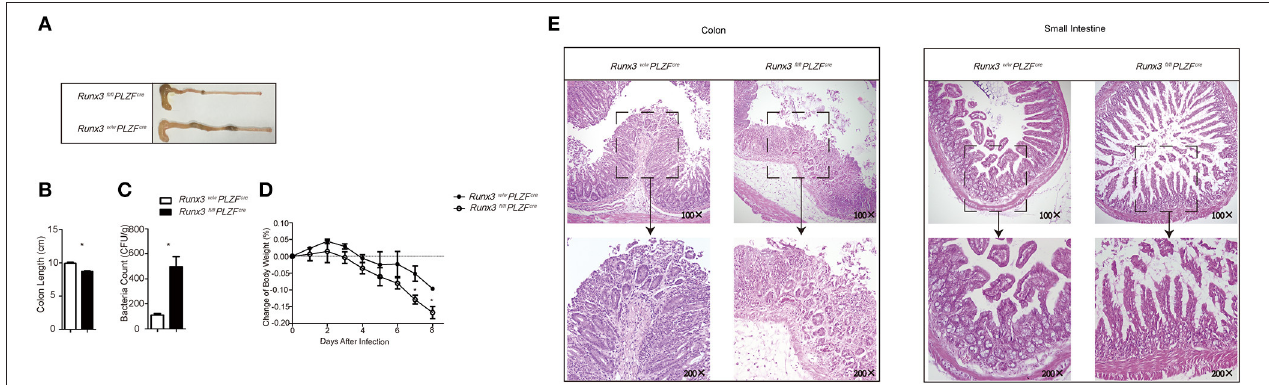
FIGURE 4 | Cell intrinsic mechanism by which Runx3 promotes intestinal group 1 ILC and NCR + ILC3 function against S. typhimurium infection. (A–E) Intestinal ILC1s from control mice and Runx3 KO mice were isolated and stimulated with IL12 and IL18 at 40ng/mL for 1 hour before injection into NCG mice through the tail vein at days − 1, 0, 1, and 5 after lavage with S. typhimurium . (A) The length of the colon, (B) statistical analysis of the colon length, (C) titre of S. typhimurium in the deiecta, (D) change of body weight, and (E) histology of the small intestine (left) and colon (right) were determined 9 days after infection. (mean ± SD of three samples in k and m; * P < 0.05 by Student’s t -test). Data are from one experiment representative of two independent experiments with similar results in (A–E)